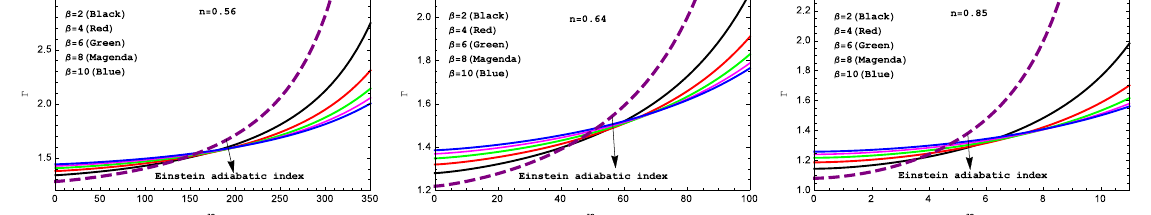
Figure 3. Behavior of the “Speed sound” with respect to the radial coordinate “r” for the compact star PSR J1614-2230 ( left panel ), Vela X-1 ( middle panel ) and 4U 1538-52 ( right panel ) corresponding to the numerical value of constants A and B from Table 2 and for different values of β .